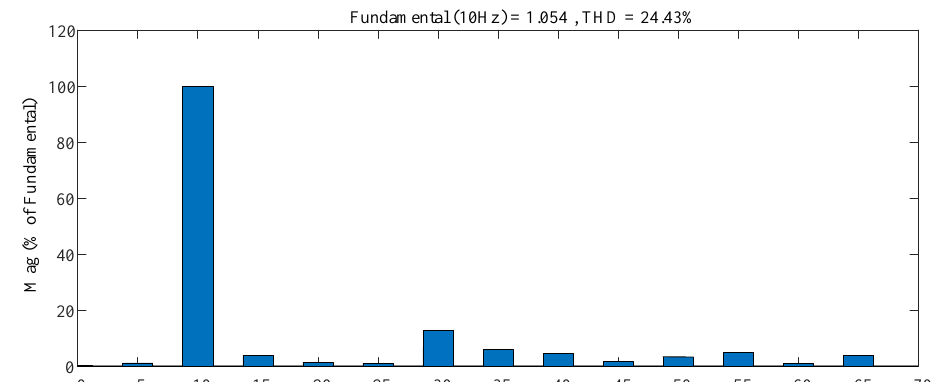
Figure 6. FFT decomposition of flux density without optimization.